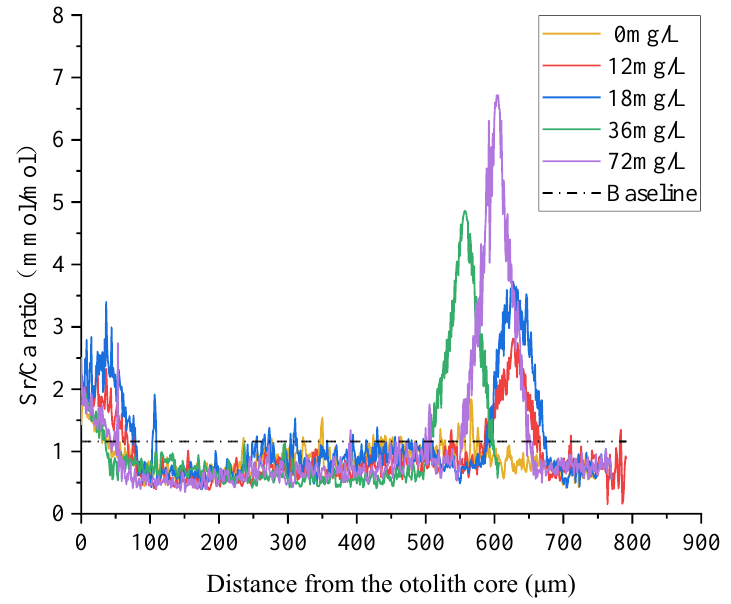
Figure 2. Sr/Ca ratios in the otoliths of T. obscurus in all groups after 25 d of immersion. Figure 2. Sr / Ca ratios in the otoliths of T. obscurus in all groups after 25 d of